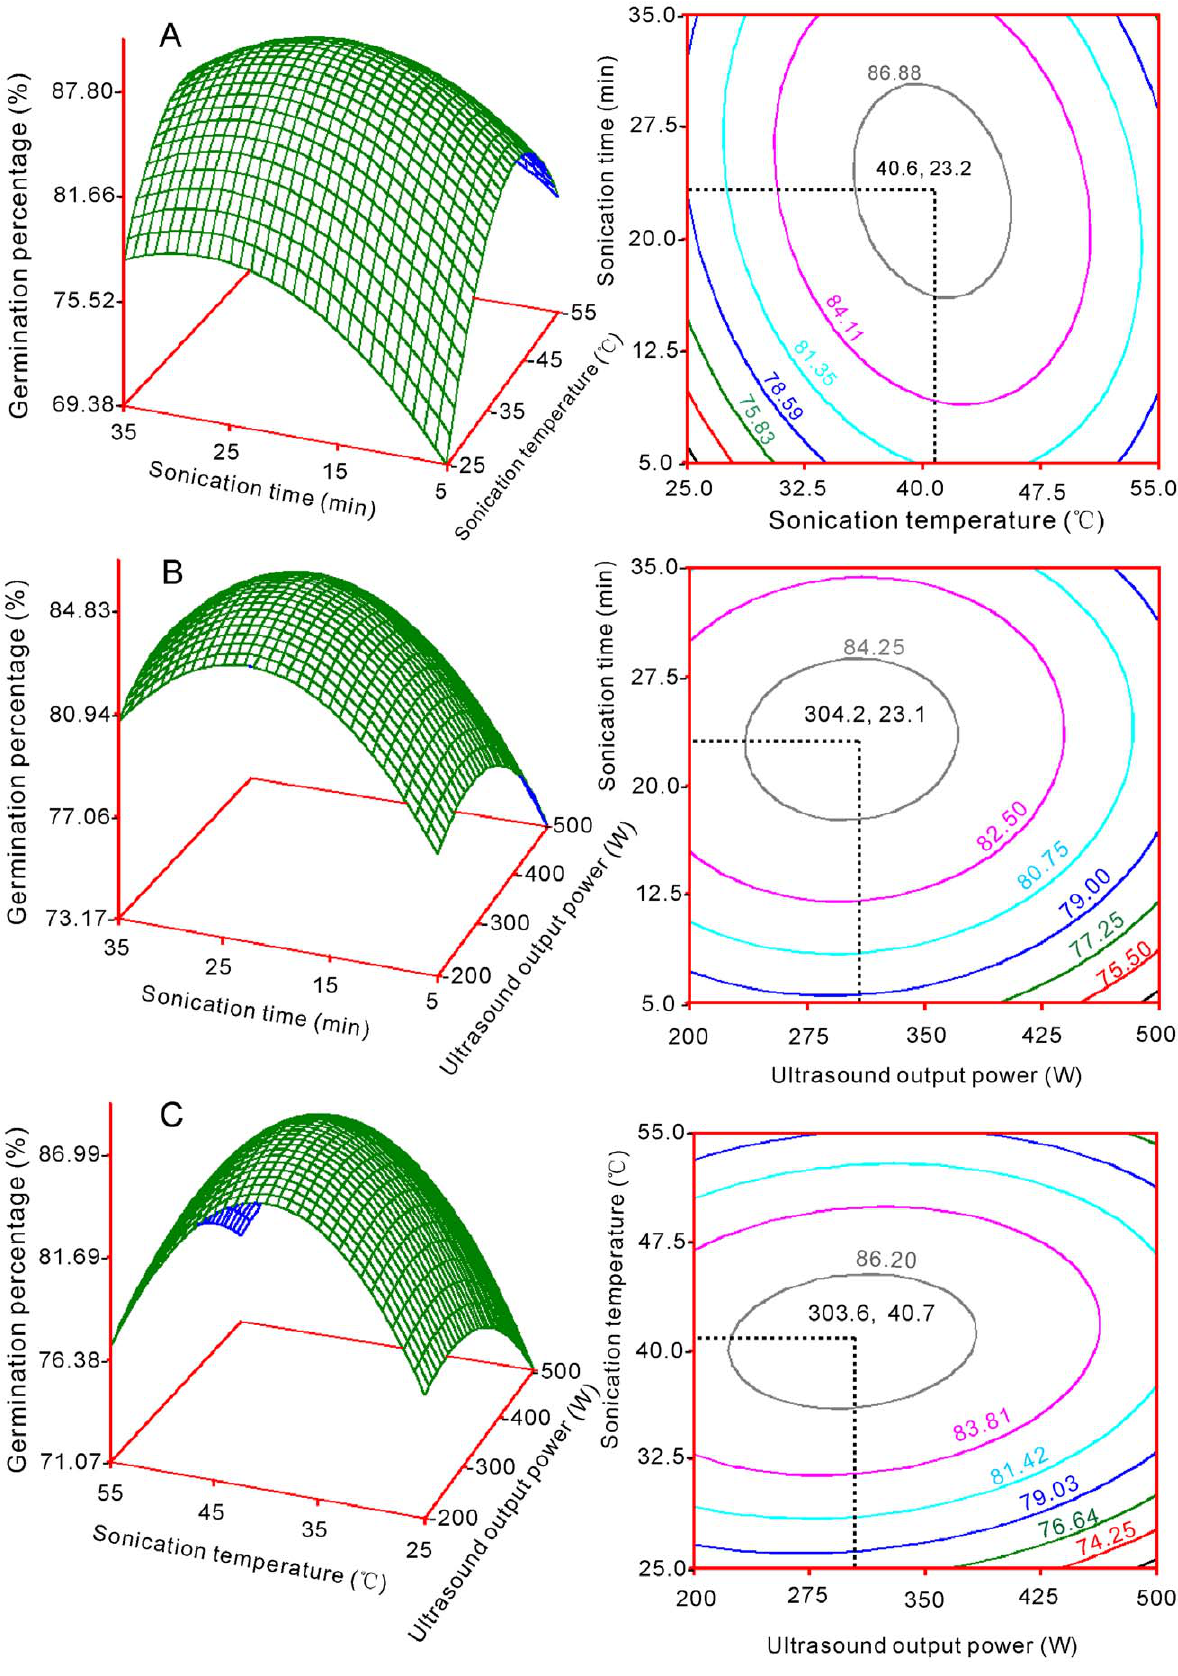
Figure 1. Response surface plots showing the parameter effects on the germination percentage in switchgrass by ultrasound irradiation. (a) Germination percentage vs. sonication time and sonication temperature; (b) Germination percentage vs. sonication time and ultrasound output power; (c) Germination percentage vs. sonication temperature and ultrasound output power. doi:10.1371/journal.pone.0047204.g001 PLOS ONE |